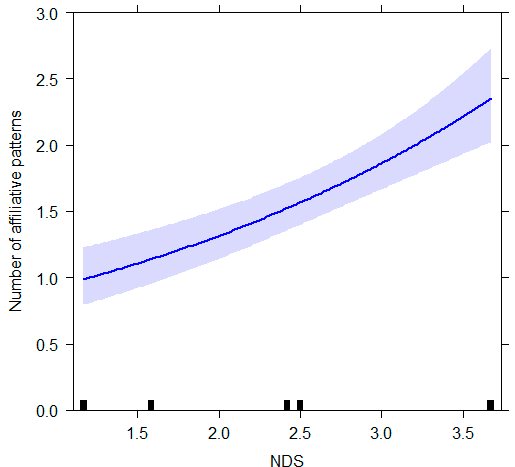
Figure 4. Effect plot of the variable having a significant influence on the number of affiliative patterns. The number of affiliative patterns (Y axis): increases as the NDS value (X axis) increases. The band represents the confidence interval.